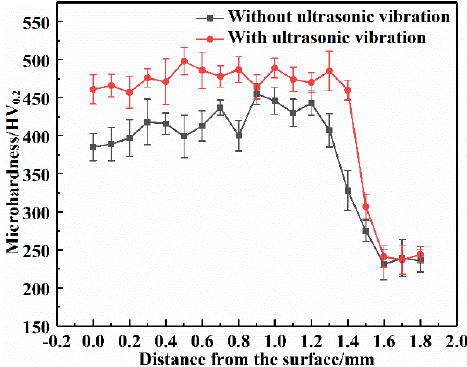
Figure 8. Microhardness distributions of the